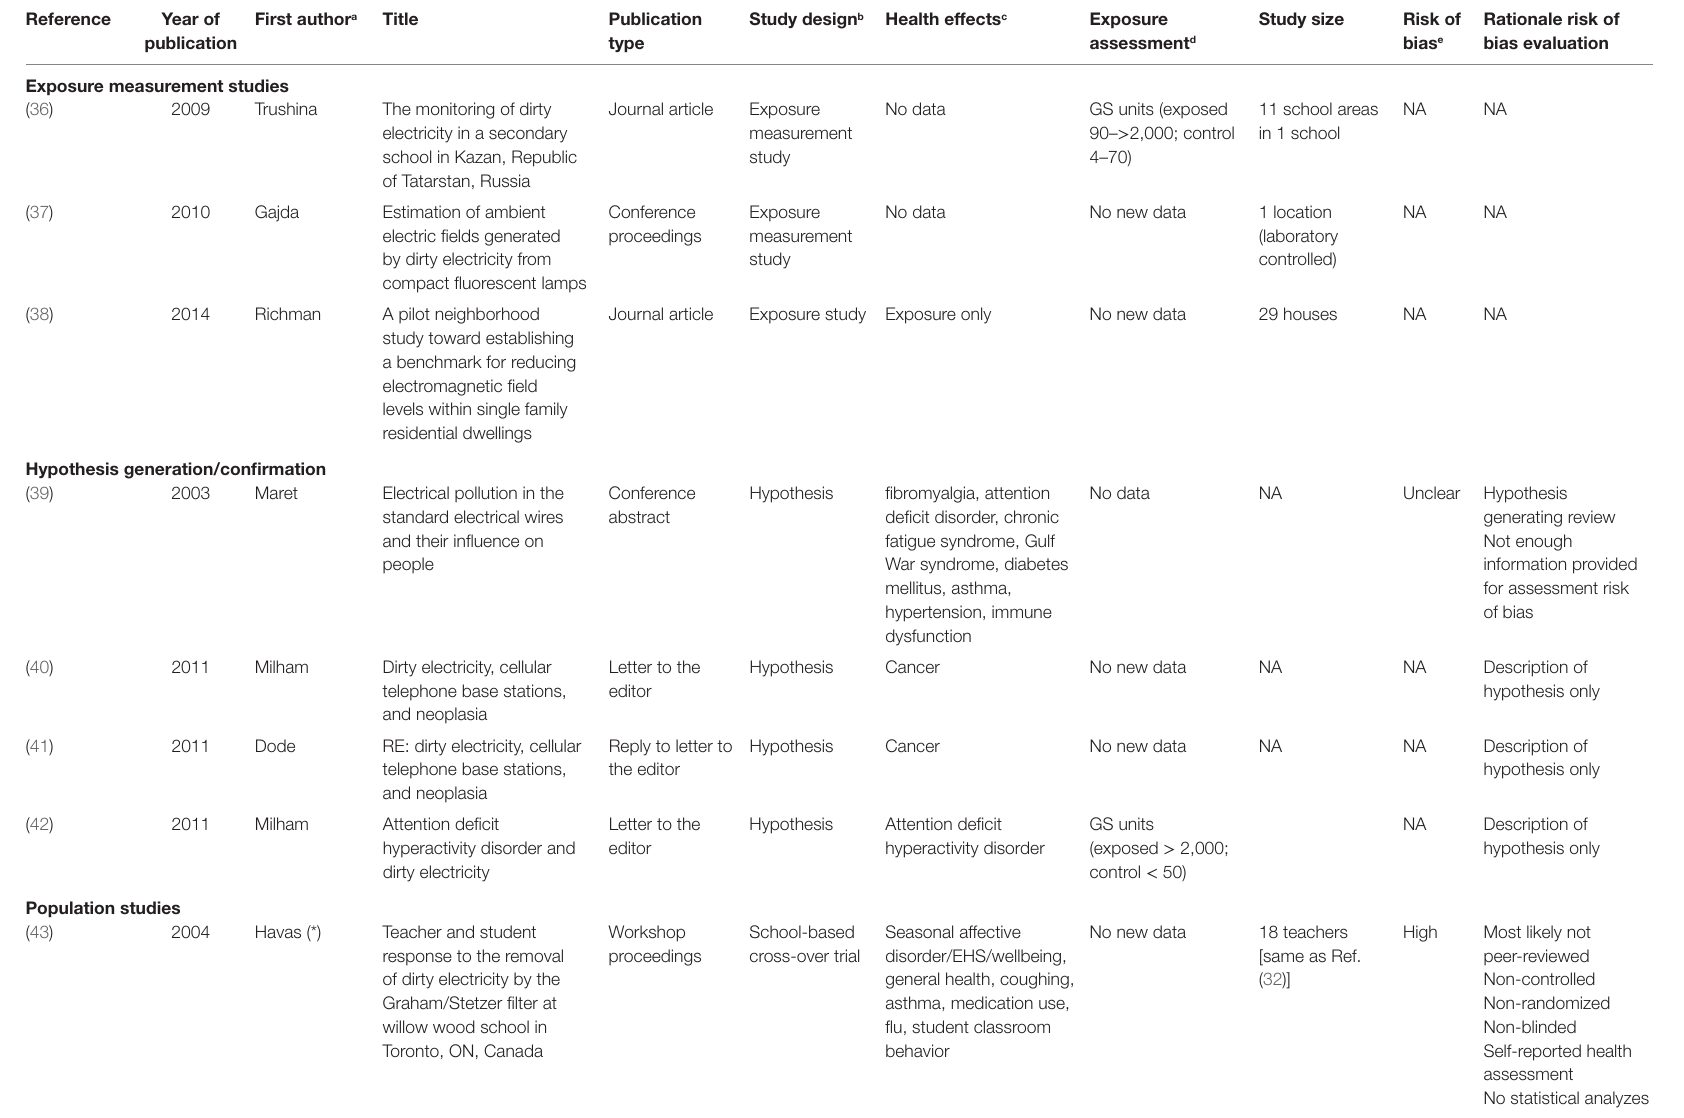
TABLe 1 | Overview of peer-reviewed publications and conference proceedings on “dirty